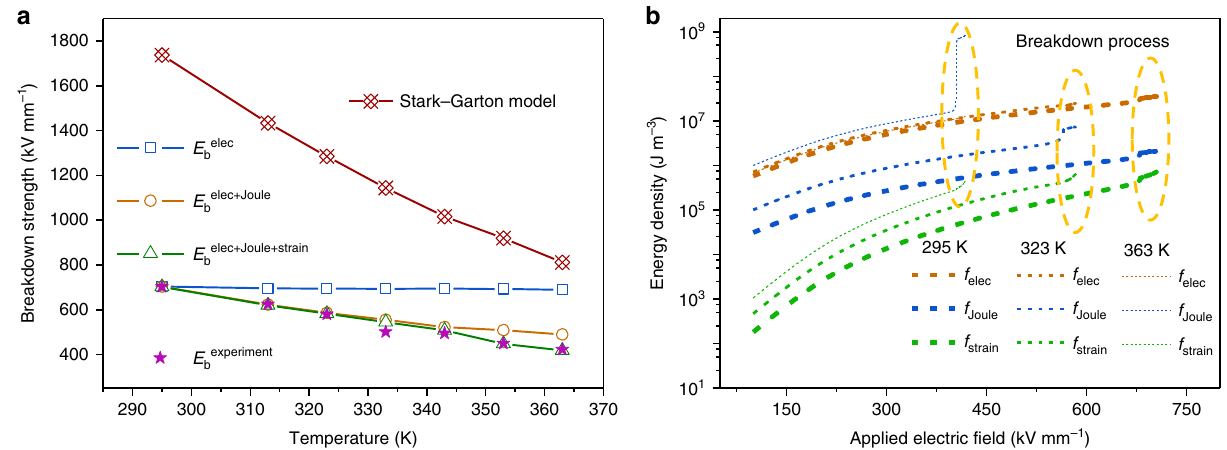
Fig. 2 Breakdown strength and energy densities of poly(vinylidene fl uoride-hexa fl uoropropylene) (P(VDF-HFP)) polymer. a The breakdown strengths 22 as functions of temperature obtained from experimental measurements and predictions from the Stark – Garton model 16 and the phase- fi eld model. E elec E elec þ Joule , and E elec þ Joule þ strain denote the breakdown strengths predicted by the phase- fi eld model considering only electric energy, the combination of b b electric and Joule heat energy, and the combination of electric, Joule heat, and the strain energy, respectively. b Comparisons of the average electric energy density, Joule heat energy density, and the strain energy density at different applied electric fi elds and temperatures. The dotted circles show the abrupt increase of energy density during the breakdown process